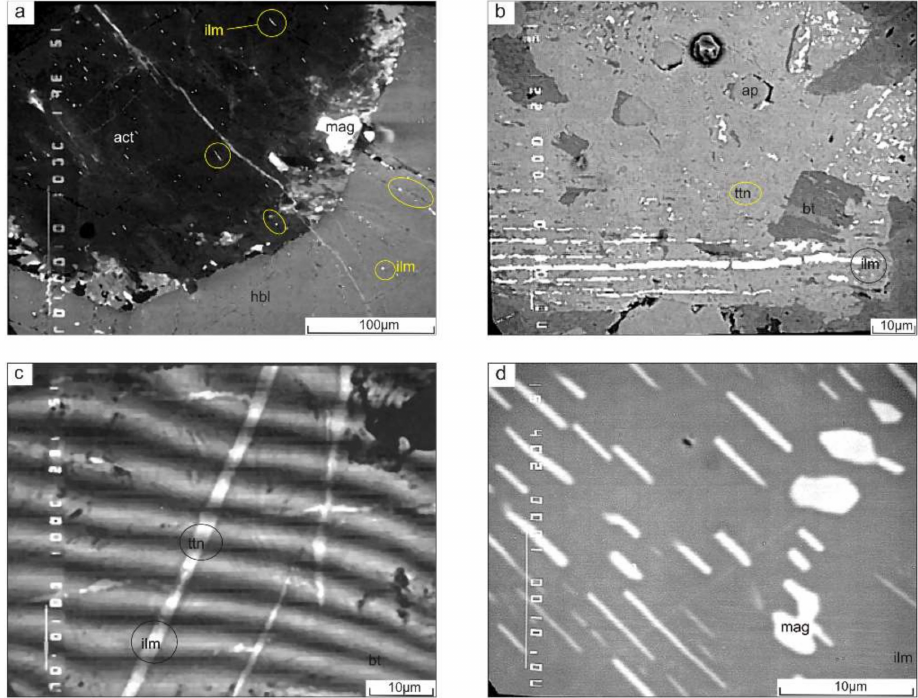
Figure 5. Backscattered electron (electron microprobe) images showing the textural relationships of the minerals. act: actinolite, ap: apatite, bt: biotite, ilm: ilmenite, mag: magnetite, ttn: titanite. ( a ) Actinolite